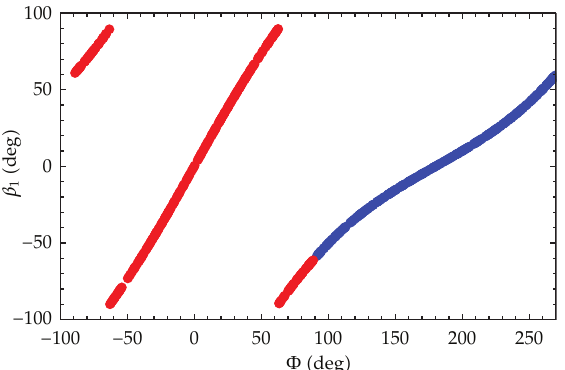
Figure 6: Relation between the phase β 1 and φ as given by the 1 σ experimental constraints (cid:2) 2.9 (cid:3) . The blue (cid:2) dark (cid:3) and red (cid:2) light (cid:3) curves correspond to the IH and NH